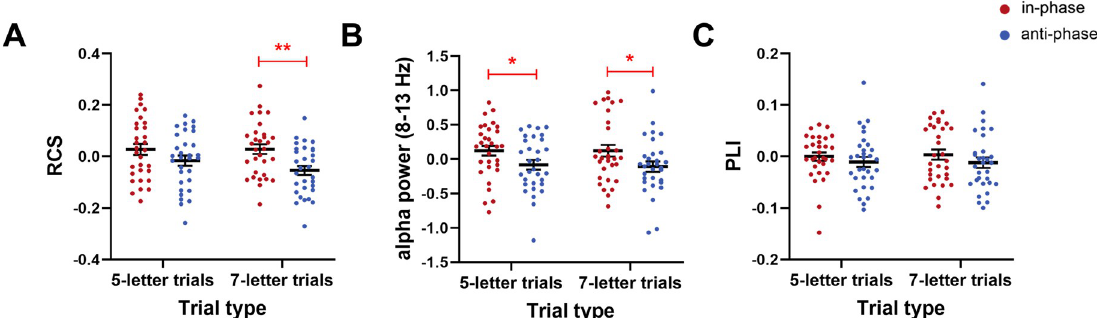
Fig 6. The behavioral and electrophysiological effects of parietal alpha tACS in Experiment 2. (A) When compared to in-phase tACS, anti-phase tACS significantly suppressed WM performance (i.e., RCS) in 7-letter trials and showed a tendency to decrease WM performance in 5-letter trials. (B) When compared to in-phase tACS, anti-phase tACS significantly suppressed parietal alpha power in either 5-letter trials or 7-letter trials. ( C ) Although not statistically significant, there was a trend for anti-phase tACS to decrease PLI when compared to in-phase tACS in either 5-letter trials or 7-letter trials. Note that all instances of the RCS, alpha power, and PLI values are given relative to the Baseline data (i.e., values after subtracting the corresponding Baseline values). Error bars represent the SEM. � Significant at p < 0.05, �� significant at p < 0.01. The underlying data supporting Fig 6 can be found in the Supporting information as S1 Data. PLI, phase lag index; RCS, rate correct score; SEM, standard error of the mean; tACS, transcranial alternating current stimulation; WM, working